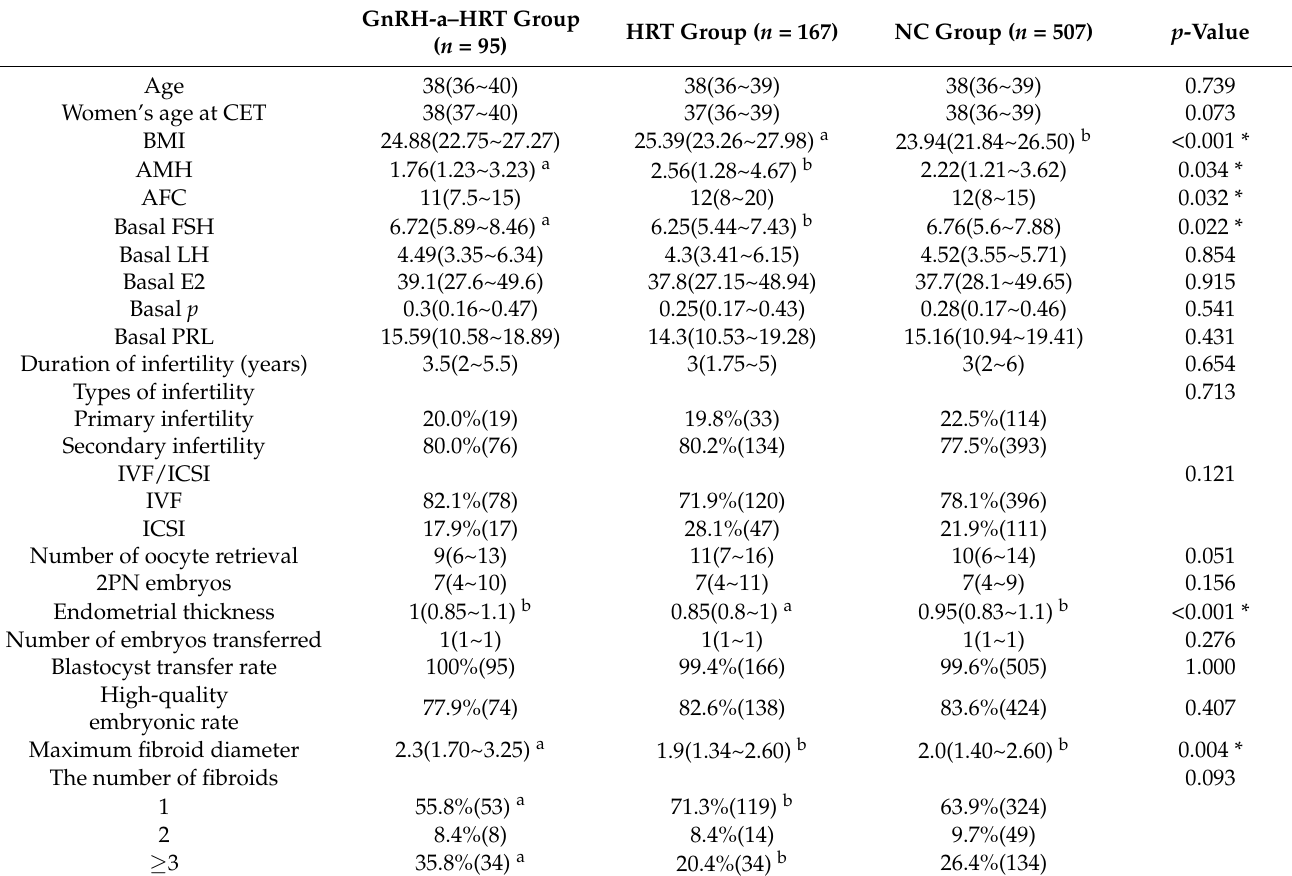
Table 1. Demographic and characteristics of patients among three endometrial preparation